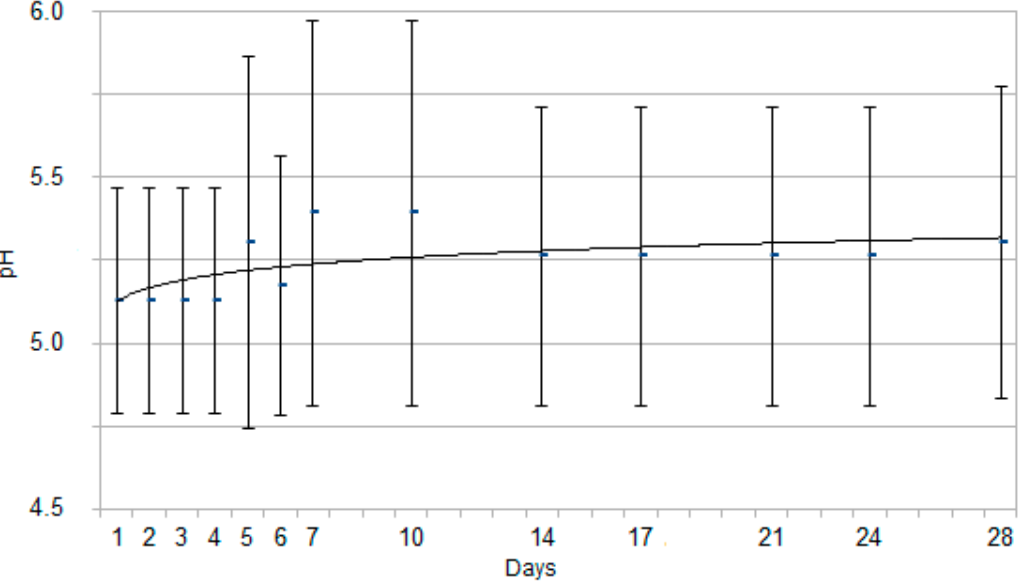
Figure 2. Graph for each time point representing pH, expressed as mean ± SD, in the 48 Great Dane puppies from birth to 28 days of age. The continuous curve represents the tendency line for this parameter.